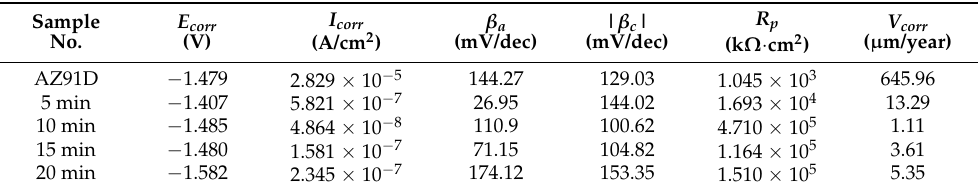
Figure 8. Potentiodynamic polarization curves of AZ91D magnesium alloy and MAO coatings in 3.5 wt.% NaCl solution under different oxidation times. Table 3. Parameter values of potentiodynamic polarization curves of AZ91D magnesium alloy and MAO coatings in 3.5 wt.% NaCl solution.